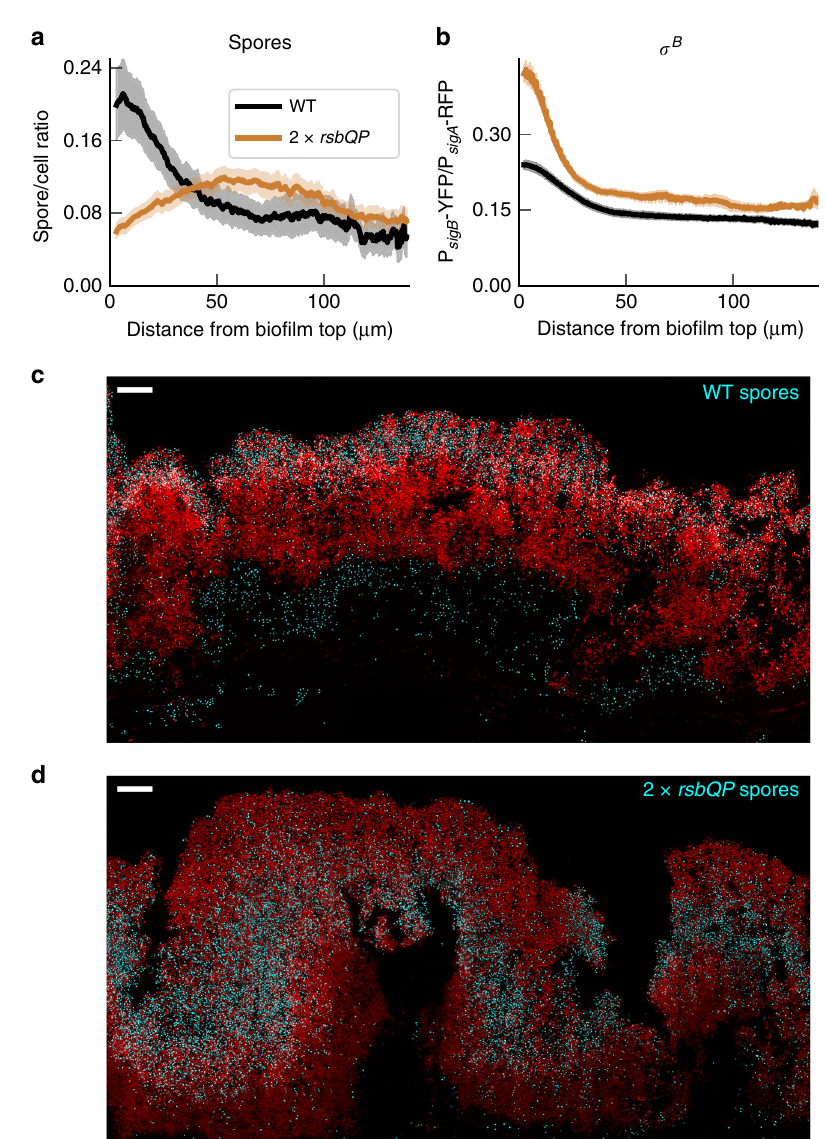
Fig. 7 Distribution of sporulating cells in bio fi lm colony is modulated by σ B expression. a Spore density at the top of bio fi lm colonies in WT and 2 × rsbQP strains. The graph represents a ratio of amount of cells identi fi ed as spores (by expression of the P sspB -YFP fl uorescent marker) to the combined amount of all cells expressing P sigA -RFP and spores (see the section “ Methods ” for details of quanti fi cation). For WT, data is replotted from Fig. 5a, n = 11 from four experiments, for 2 × rsbQP data, n = 12 from four experiments. Error bars represent SEM. b Doubling of rsbQP gene copy number increases and sharpens σ B expression gradient in bio fi lm colonies. The graph represents a ratio of P sigB -YFP to P sigA -RFP expression in WT (black) and 2 × rsbQP (brown) backgrounds in bio fi lm colonies as measured from the distance from the colony top. (WT data n = 13 from three experiments, 2 × rsbQP n = 7 from 1 experiment). Error bars show the SEM. Scale bars are 25 μ m. c , d representative images of the spore pattern in a WT and 2 × rsbQP bio fi lm respectively, P sigA -RFP in red and P sspB -YFP in cyan. All samples are from the central part of the bio fi lm and collected at 48 h after inoculation. Note that in c , between the bio fi lm and agar, is a layer of spores. This is typical of WT bio fi lms and is not re fl ected in the spore gradient a since there are no cells to compute a ratio. The full context for c and d is shown in Supplementary Fig. 12. Source data are provided as a Source Data fi built-in linear unmixing feature of the confocal microscope to reduce bleed- through of signal. For single cell imaging of bio fi lm slices (Figs. 3, 11 and Supplementary Figs. 5, the analysis. When analysing single cell data we discard data from the fi rst frames 6) we used a Zeiss LSM700 with an oil immersion ×63 Plan Apochromat (NA 1.4) of the movie (before 8 cells) to allow cells to adjust to growth on the agarose pads and to avoid inclusion of cells with fl uorescent protein levels that could re fl ect the objective. Images were acquired using sequential imaging with a 488 nm laser at 2% previous plankonic growth or the transition to the agarose pad. power and a 555 nm laser at 2% power. The pinhole was 47 μ m for both channels. Images were stored as 16 bit images with 1 pixel representing 0.05 μ m. The beam splitter for the yellow channel was MBS 405/488/555/639 DBS1: 550nm, and for Thin slice imaging . Imaging of bio fi lm slices (Fig. 2) with fl uorescent reporters the red channel MBS 405/488/555/639 DBS1: 600 nm. To quantify sporulation was performed using a Zeiss LSM780 laser scanning confocal microscope with a (Fig. 7, Supplementary Figs. 10 and 12) we made long tilescans of bio fi lm slices. dry 10x Plan Apochromat (NA 0.45). Images were acquired using sequential Regions of bio fi lm were excluded from analysis if they were physically damaged imaging and saved as 16 bit images with 1 pixel representing 0.59 μ m. For single during sectioning. We also excluded regions where the bio fi lm folded over on itself cell imaging with three fl uorescent reporters (Fig. 5, Supplementary Fig. 9) we used or where the top was not easily discernible. an oil immersion ×63 Plan Apochromat (NA 1.4) objective. We used the LSM780